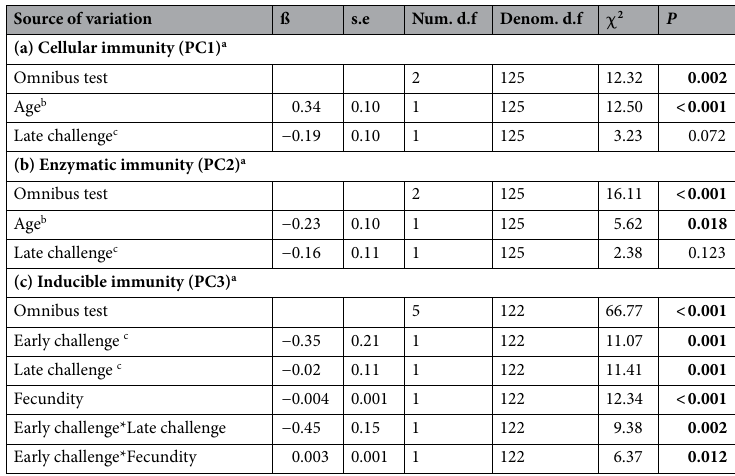
Table 2. General Linearized Models (GLMs) for the summary immune values obtained from the principal component analysis (cellular immunity as PC1; enzymatic immunity as PC2 and inducible immunity as PC3) as a function of age of haemolymph sample (40 versus 60 days post emergence), their early-life immune treatment (control versus early challenge), their late-life immune treatment (control versus late challenge),